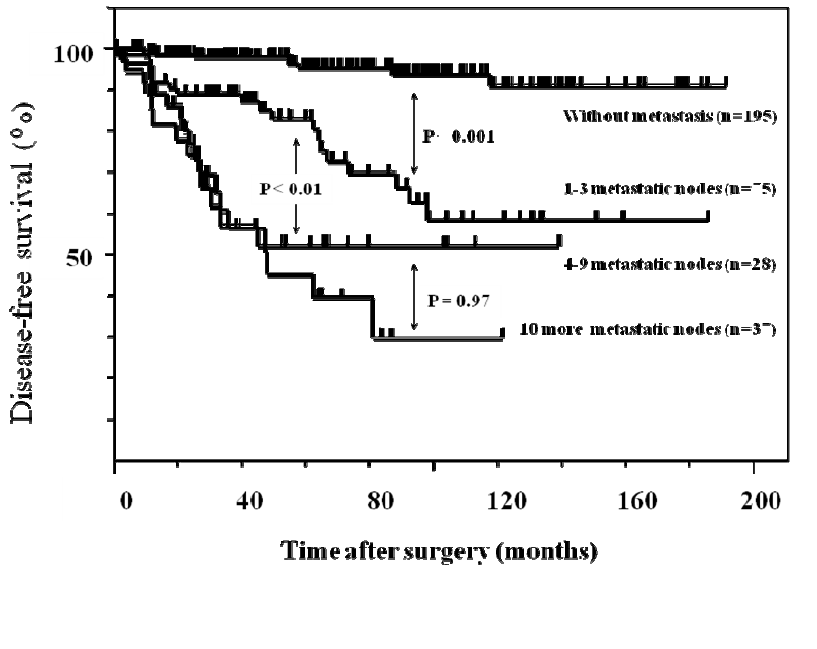
Figure 3. Five-year disease-free survival curves according to the number of lymph node metastases by histologic